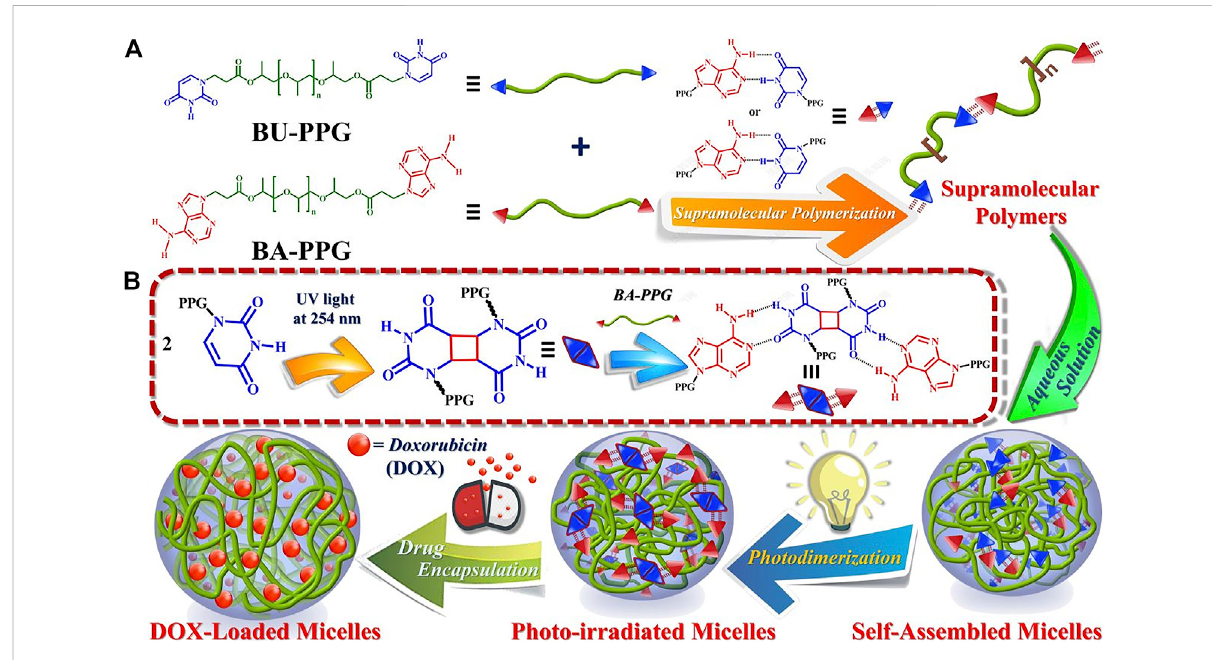
FIGURE 4 Schematic illustration of micelle formation and drug loading/release by photosensitive BA-PPG/BU-PPG in aqueous buffer solutions. Adapted with permission from Alemayehu et al.